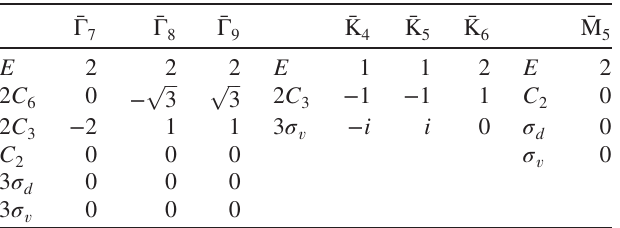
TABLE II. Character tables of irreps at high symmetry mo- menta in SG P 6 mm (with TRS). The little co-groups at Γ , K, and M are C 6 , C 3 , and C 2 respectively. Here, C 6 , C 3 , C 2 represent v v v the sixfold, threefold, and twofold rotations, and σ represent the two classes of mirrors.